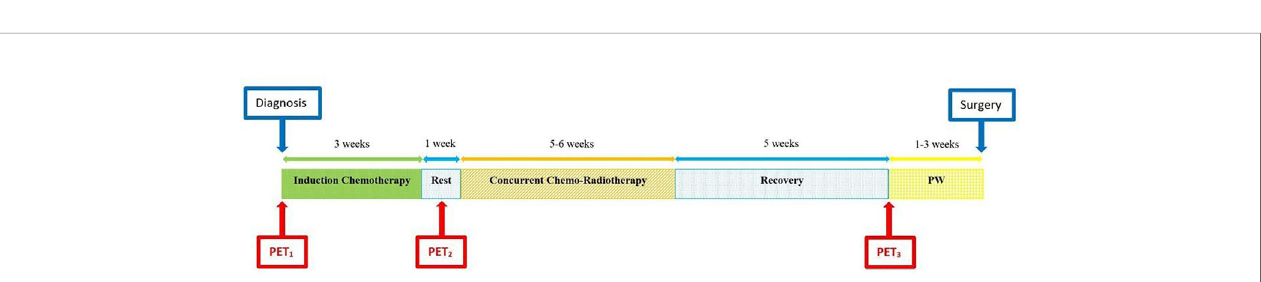
FIGURE 1 | Schematic diagram of the neoadjuvant chemo-radiotherapy protocol schedule. CHT, chemotherapy; T, docetaxel; C, cisplatin; F, 5 fl uorouracil; c.i., continuous infusion; RT, radiotherapy. Doses of 5 fl uorouracil (F) are given as mg/m 2 /day. § RT 50-50.4 Gy in 25 – 28 fractions; * if 28 RT fractions are used.